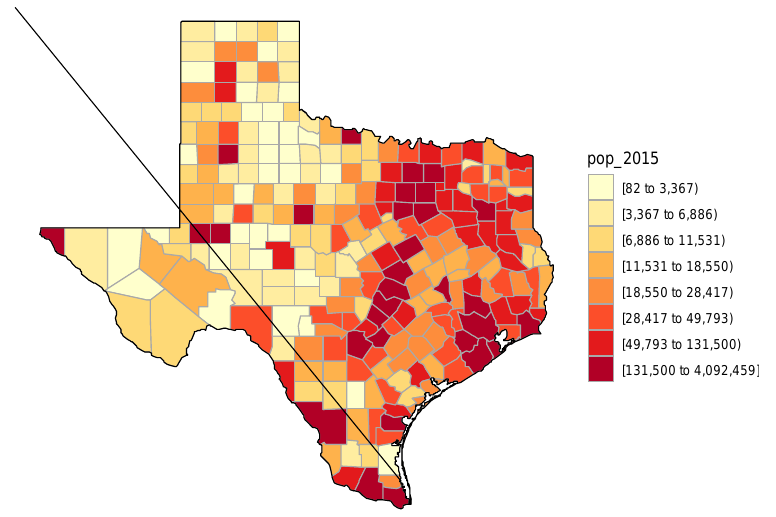
Figure 3. Distribution of Population Intensity in Texas.